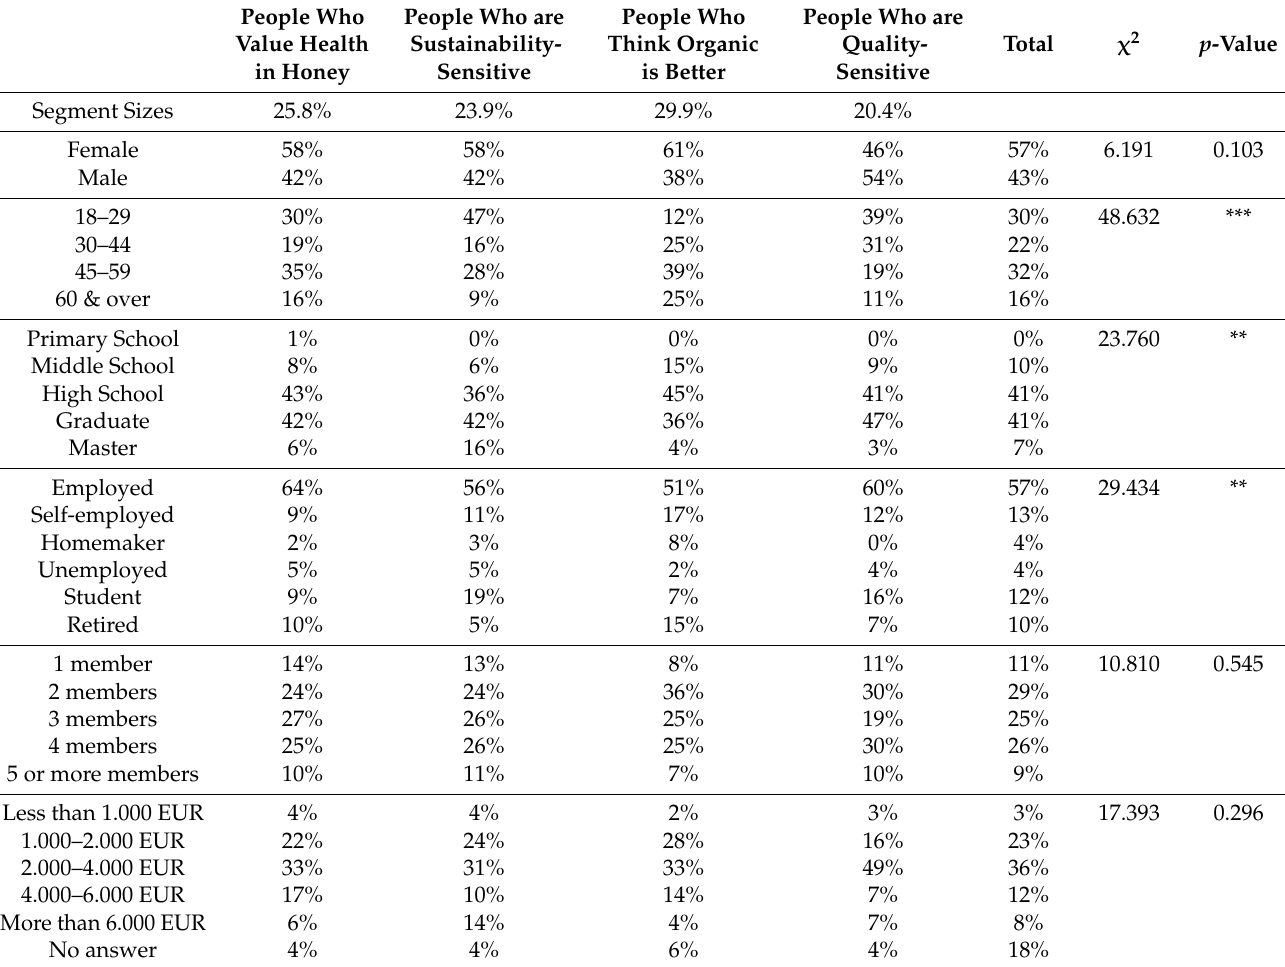
Table 5. Description of the sample and cluster